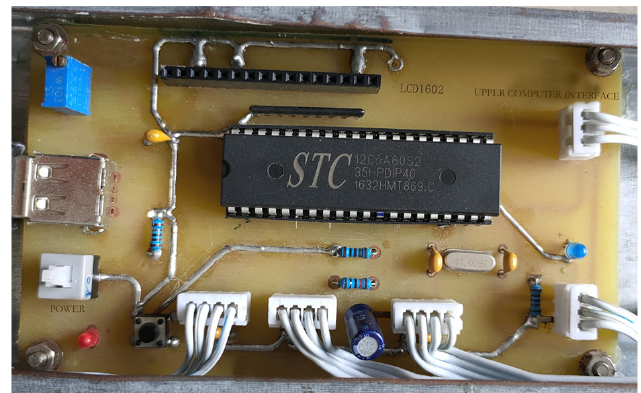
Figure 5. Physical drawing of control module.